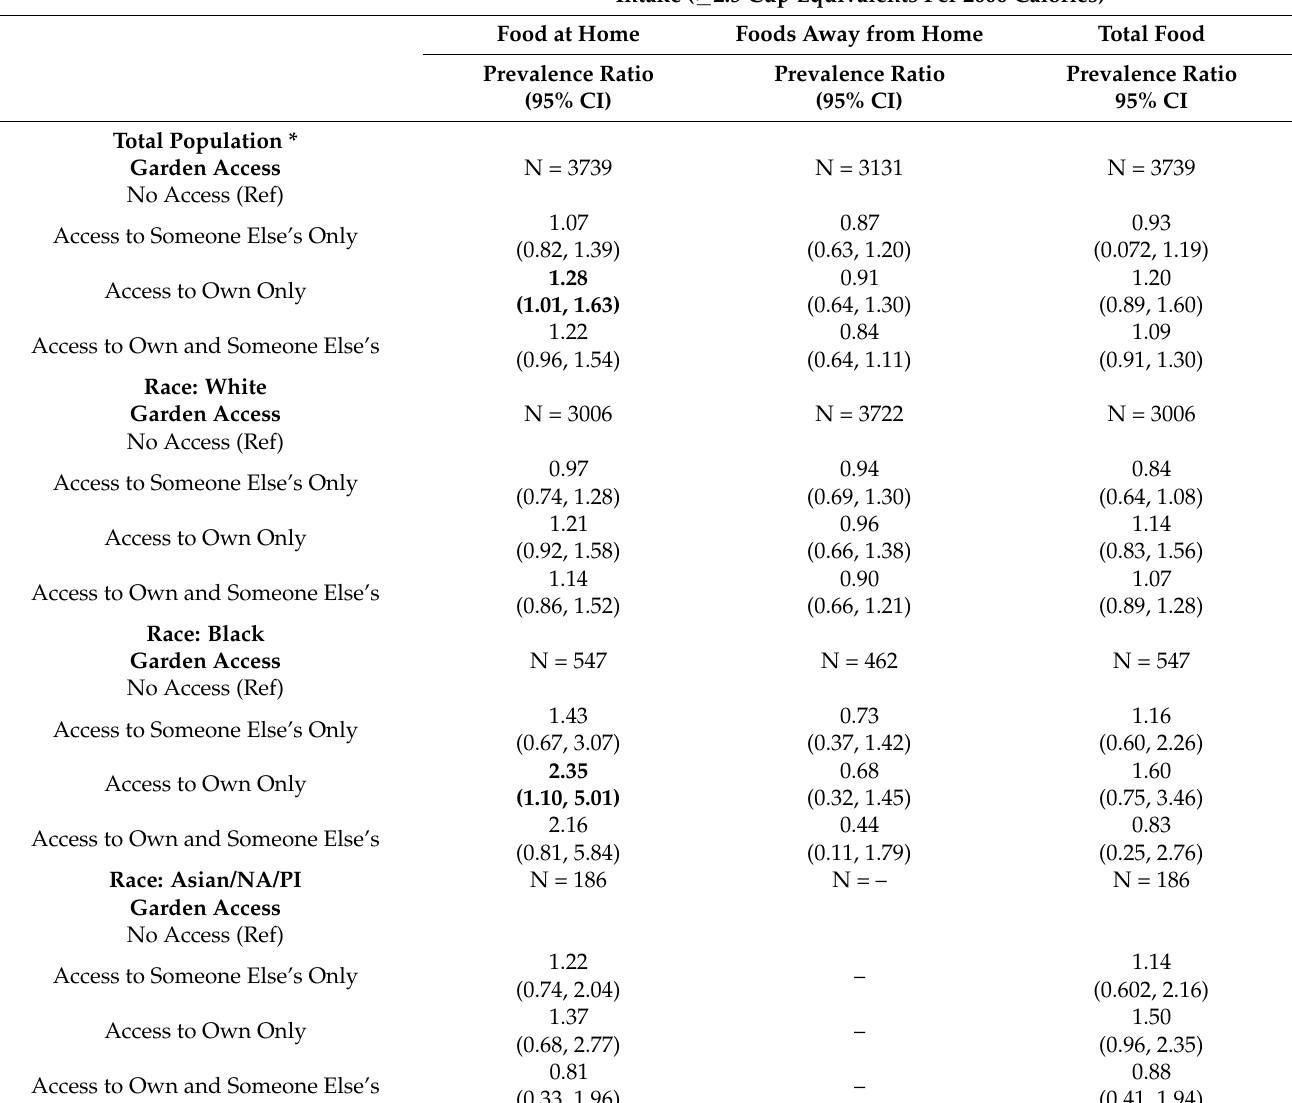
Table 2. Adjusted associations between garden access and primary respondent vegetable acquisitions in the National Household Food Acquisition and Purchase Survey (FoodAPS) for total population and stratified by race. Prevalence Rate Ratio of Acquiring Vegetables to Meet USDA